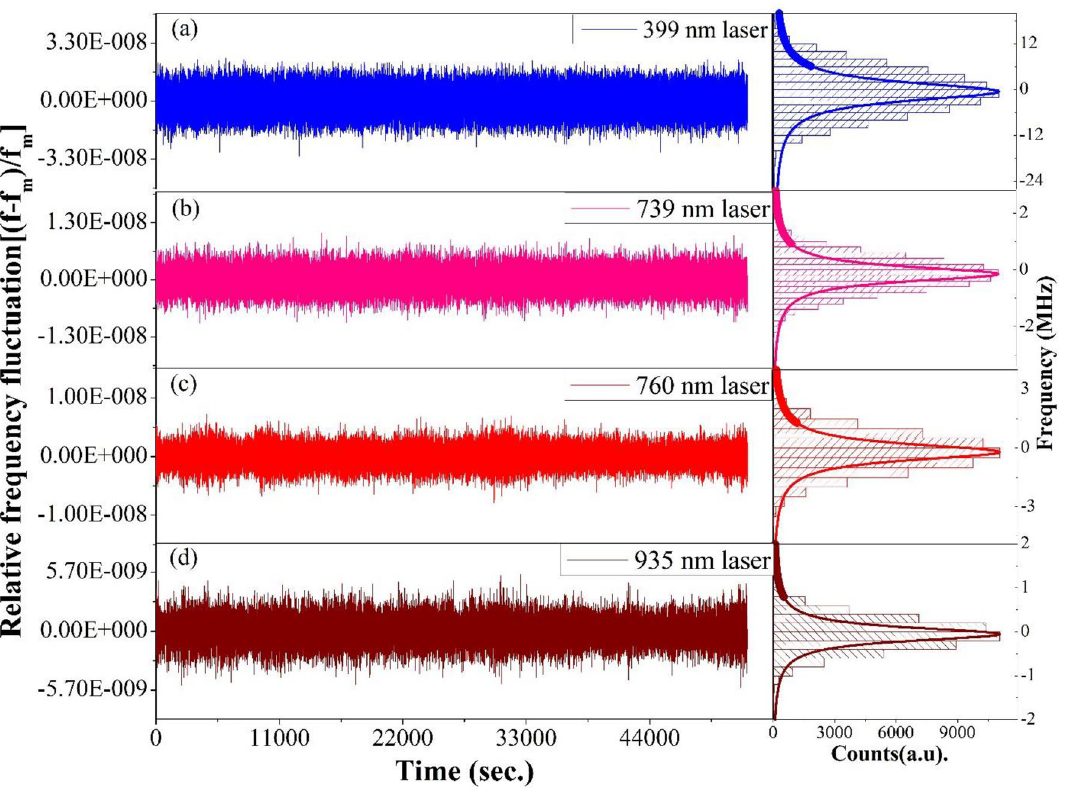
Figure 4. Relative frequency fluctuations of the frequency stabilized lasers operating at ~ ( a ) 399 nm, ( b ) 739 nm, ( c ) 760 nm and ( d ) 935 nm respectively. Corresponding histograms (Gaussian) show distribution of frequency offsets with respect to the central frequencies for each